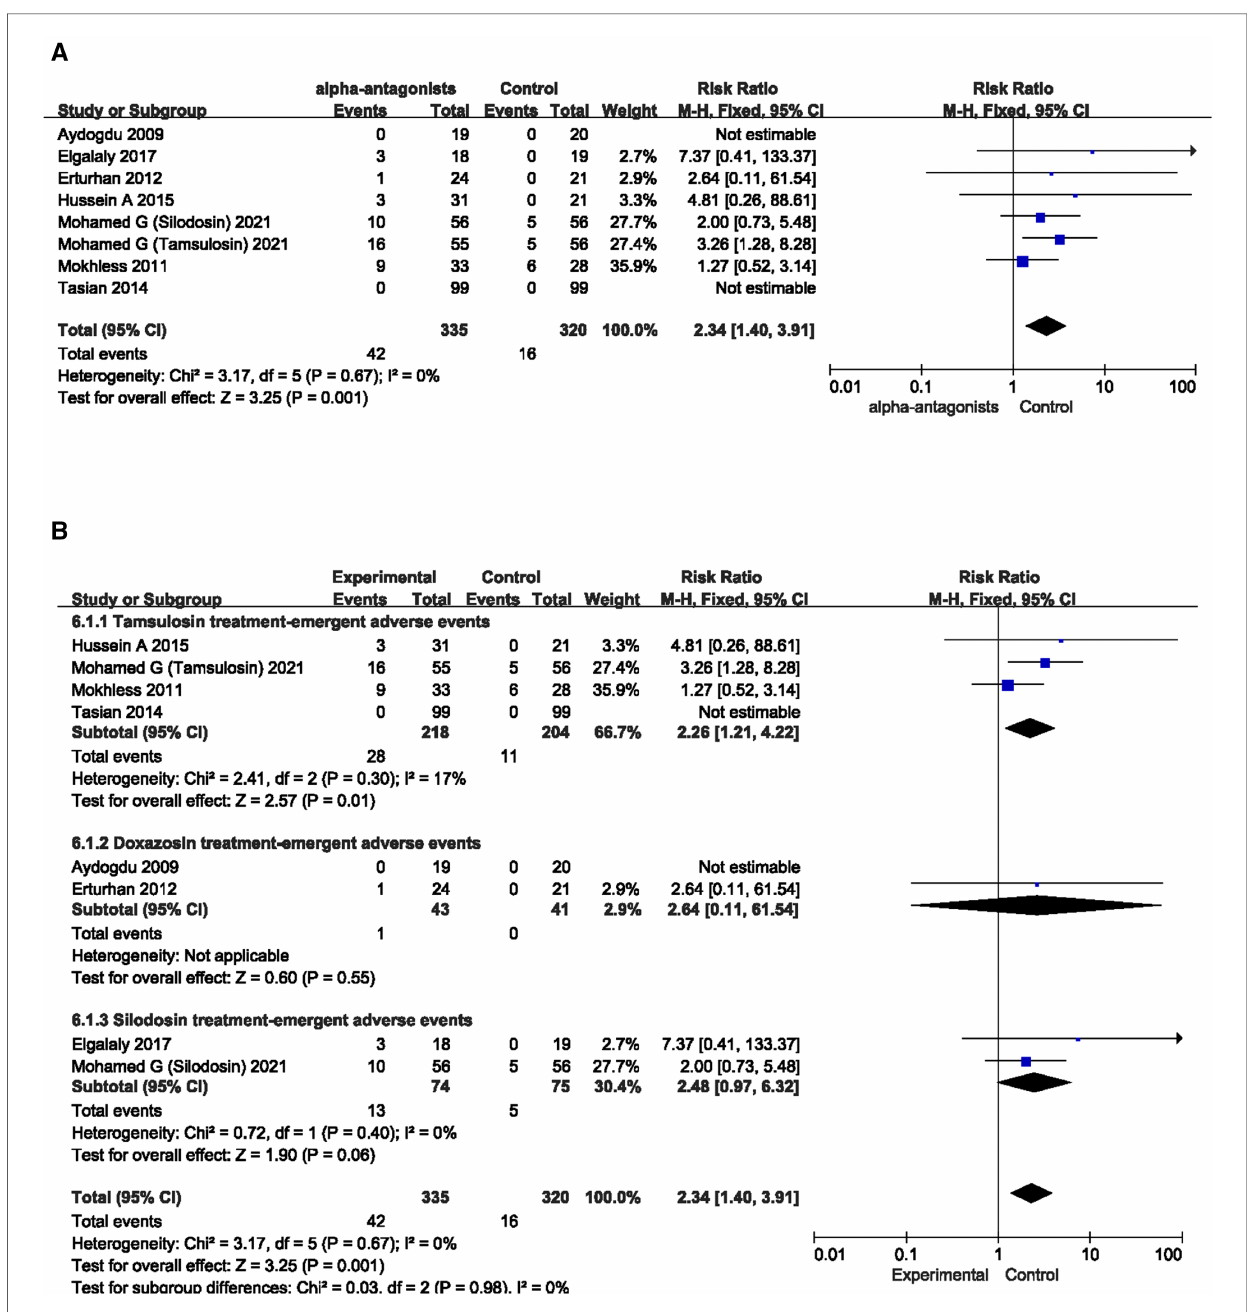
FIGURE 5 Forest plot comparing differences in treatment-emergent adverse events between 438 adrenergic alpha-antagonists and control groups. ( A ) Effects of treatment with adrenergic 439 alpha-antagonists on treatment-emergent adverse events compared with control group. ( B ) Subgroup analysis of the effects of adrenergic alpha-antagonists on the 440 treatment-emergent 441 adverse